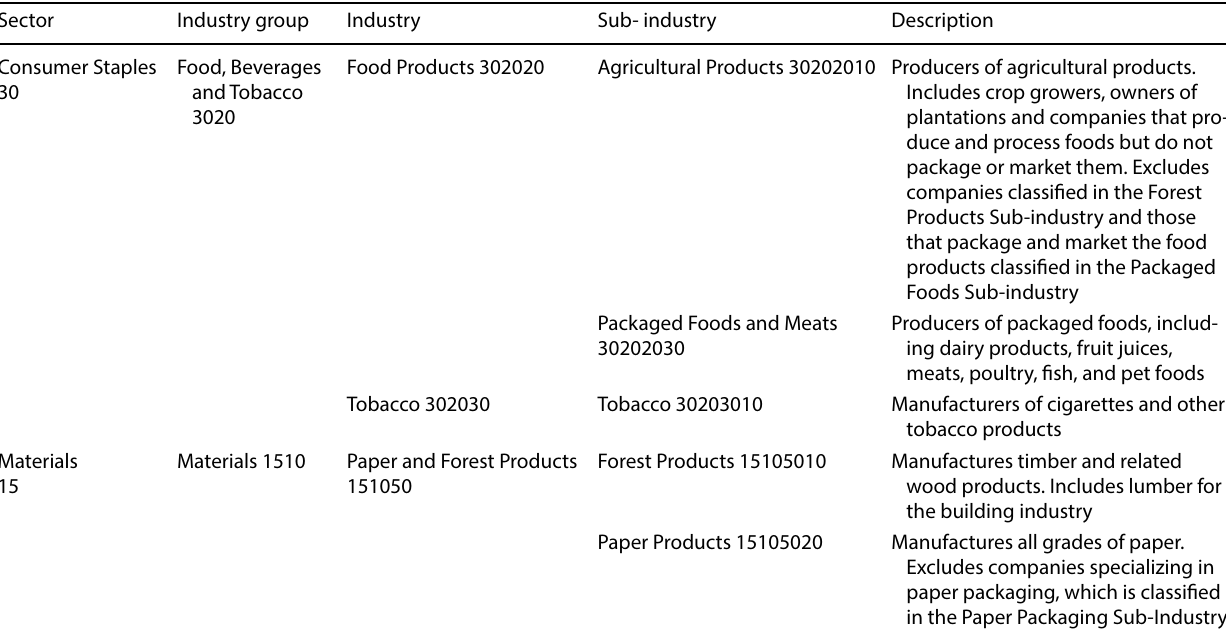
Table 3 Relevant Global Industry Classification Standard (GICS)